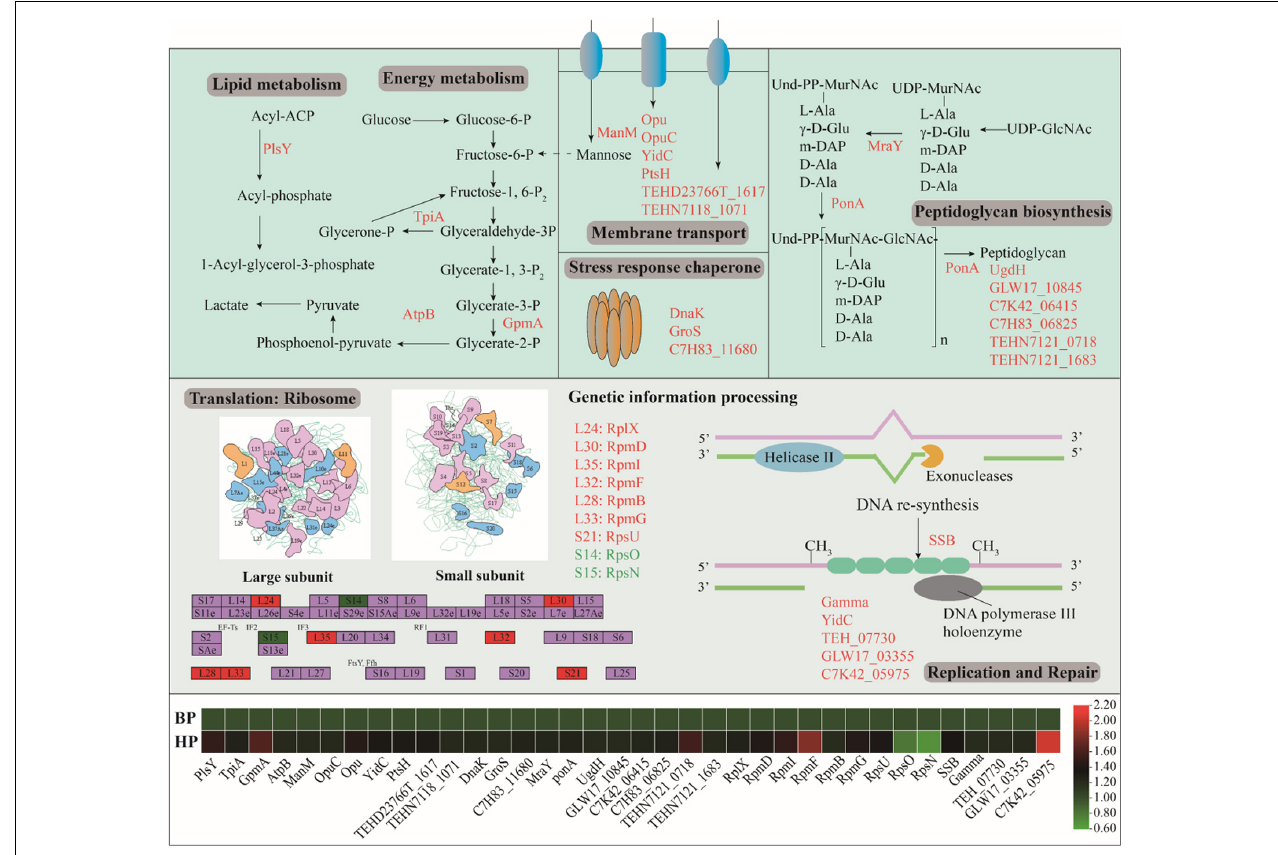
FIGURE 6 | Effect of heat preadaptation on protein expression involved in cellular metabolism, membrane transport, peptidoglycan biosynthesis and genetic information process. The up- and down-regulated proteins after heat preadaptation are shown in red and green, respectively. The changes of proteins in the pathway are shown in the heat map. BP (before preadaptation): cells harvested at mid-exponential growth phase without any treatment; HP (heat preadaptation): cells harvested at mid-exponential growth phase were preadapted at 45 ◦ C for 1.5 h.